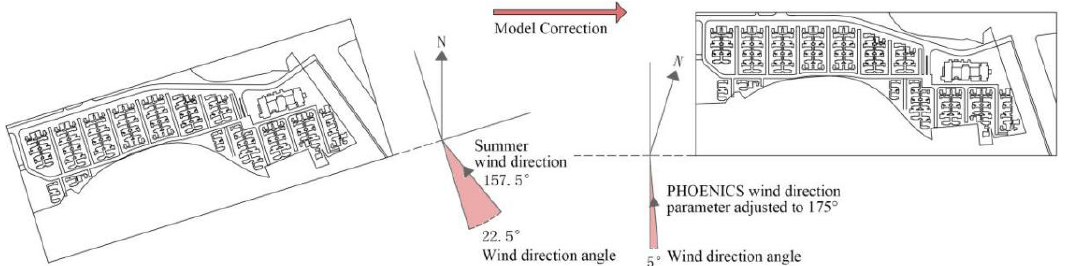
Figure 5. Schematic diagram of site simulation correction.